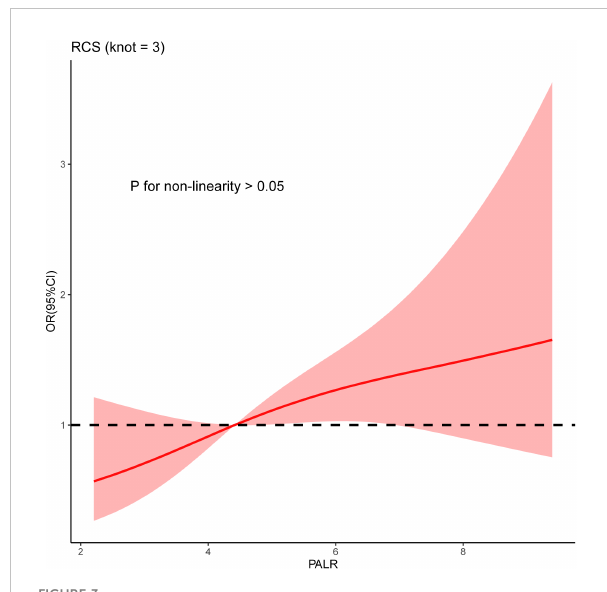
FIGURE 3 The non-linearity relationship between PALR and the risk of LNM was explored using RCS.